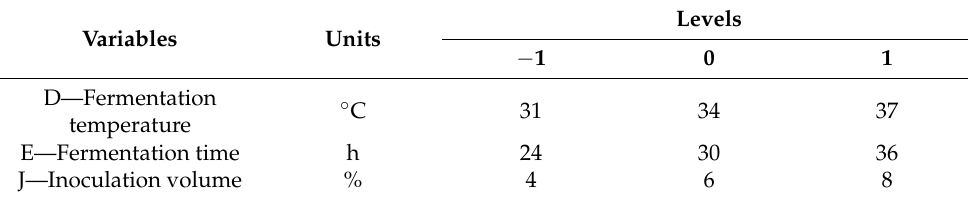
Table 2. Coded and real values of variables in the